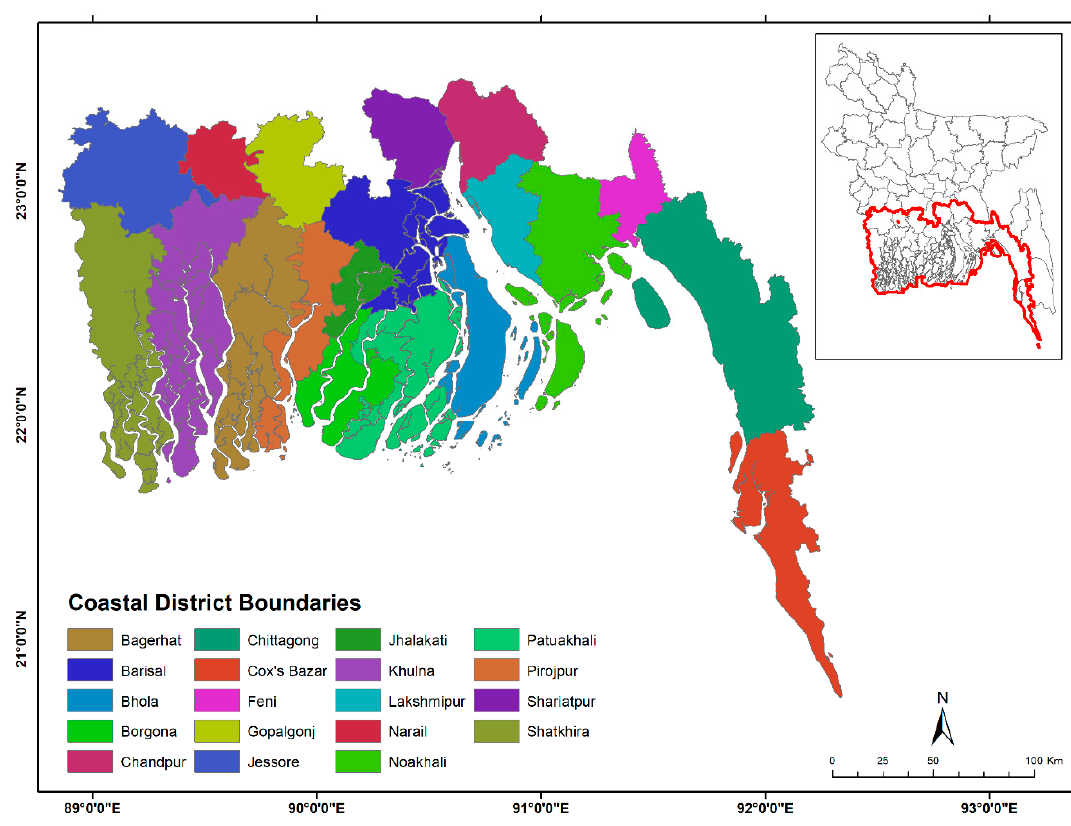
Figure 1. Location of the study area showing the coastal districts of Bangladesh.